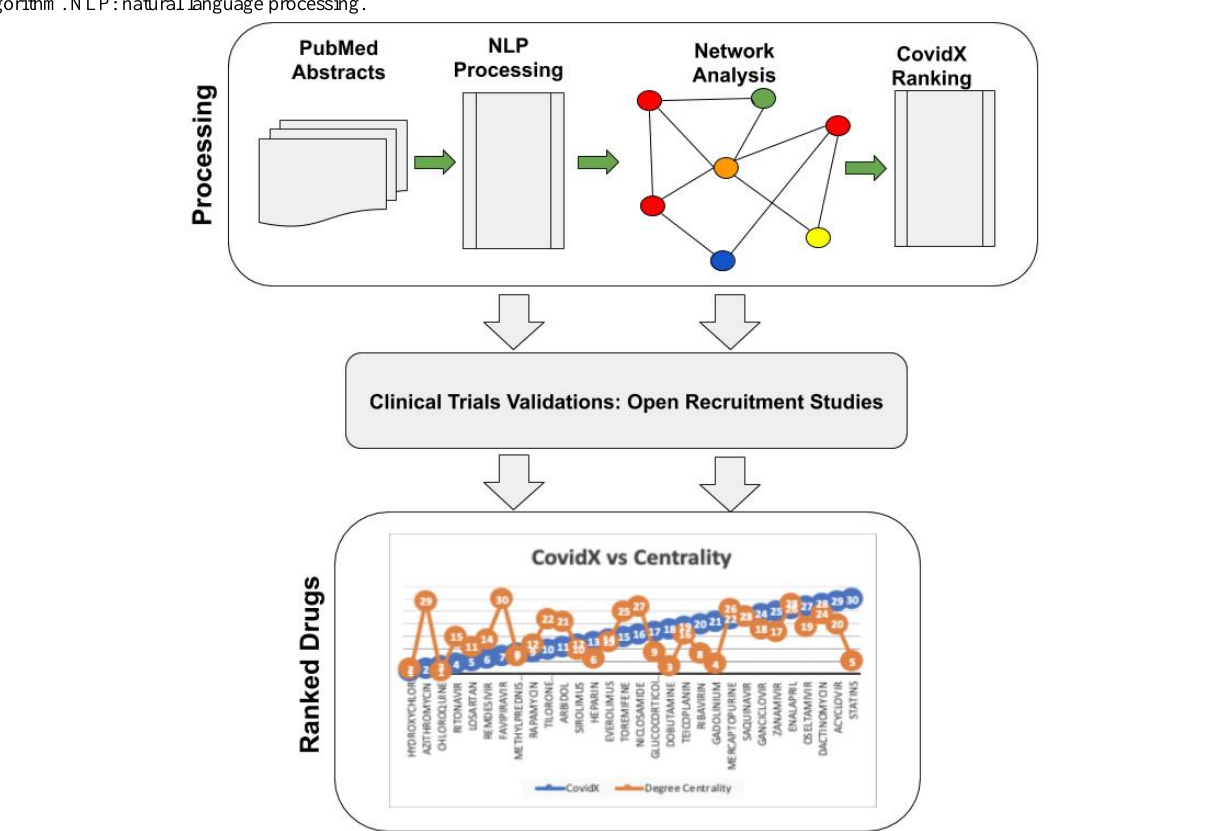
Figure 1. Workflow diagram showing how the processing of PubMed abstracts using NLP produces a network of drugs (symbolized in red) and various biological features (in various colors). The workflow shows the clinical trials validation steps before it produces the final ranking results of the CovidX algorithm. NLP: natural language